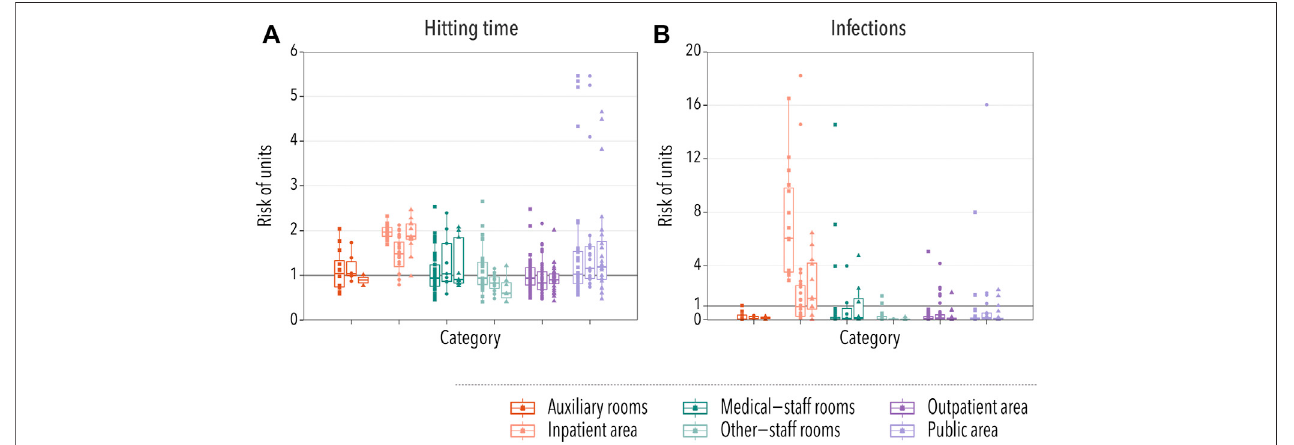
FIGURE 3 | Spatial spreading of a disease in hospital settings. In all cases, each box-plot represents the median and the interquartile range of the risk associated withunitsundereachcategory.Dotsindicatetheaverageriskofeachindividuallocationwithinthecategory,withsquares,circles,andtrianglesrepresentinghospitalsA, B, and C, respectively. In panel (A) , the relative risk of infection is gauged using the hitting time, while in panel (B) it is measured by taking into account the number of infections produced withineach unit. The categoryofaunit wasprovided bythemanagement ofhospitalA, and thesamegrouping criteria wereused for theother hospitals. Two groups represent patient-care areas ( inpatient area or outpatient area ) while the other four groups are composed of units that are predominantly non- patient-care areas.